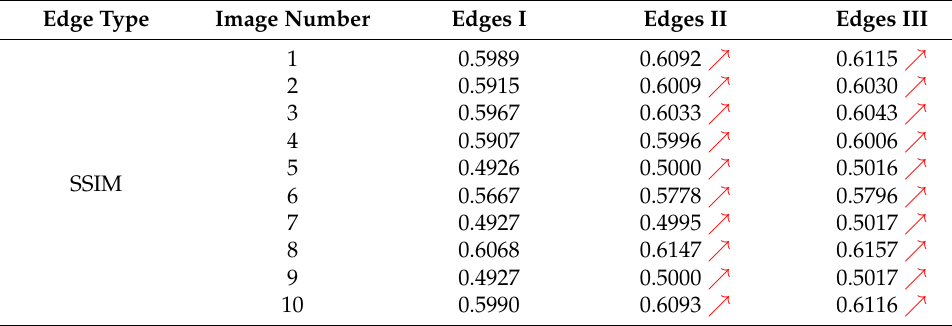
Table 4. The SSIM values of each type edge for randomly selected images. Edge Type Image Number Edges I